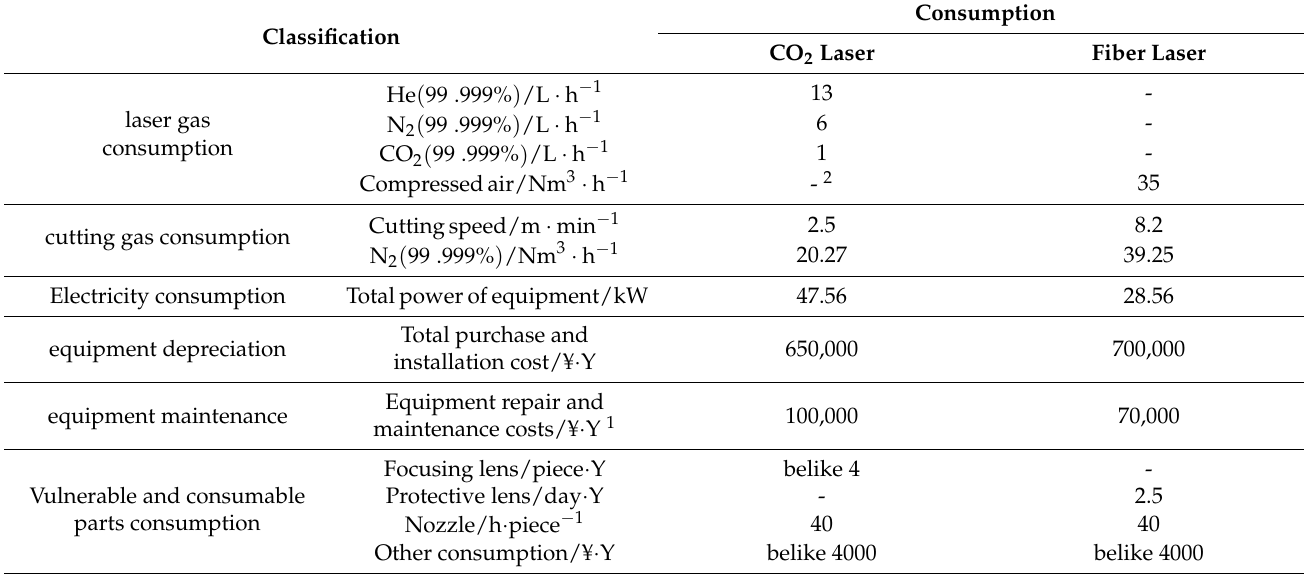
Table 1. CO 2 laser and fiber laser cutting process cost